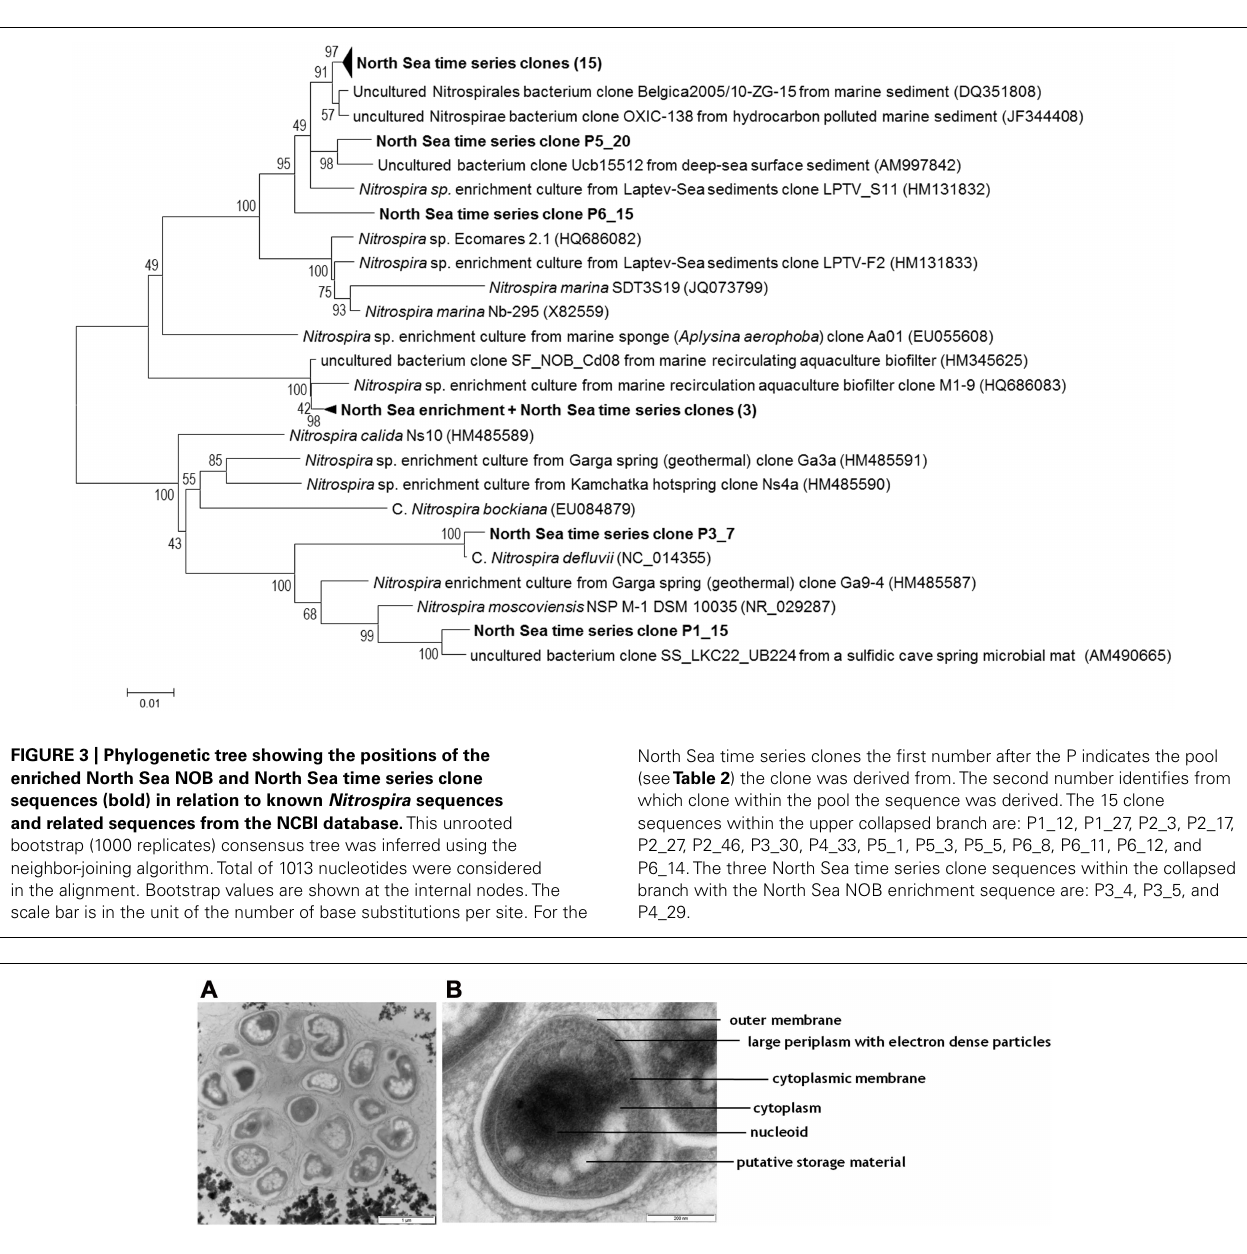
FIGURE 4 |Transmission electron micrographs of cells from the NOB enrichment. (A) an overview picture of a representative aggregate of cells; (B) one representative cell with morphological features indicated.